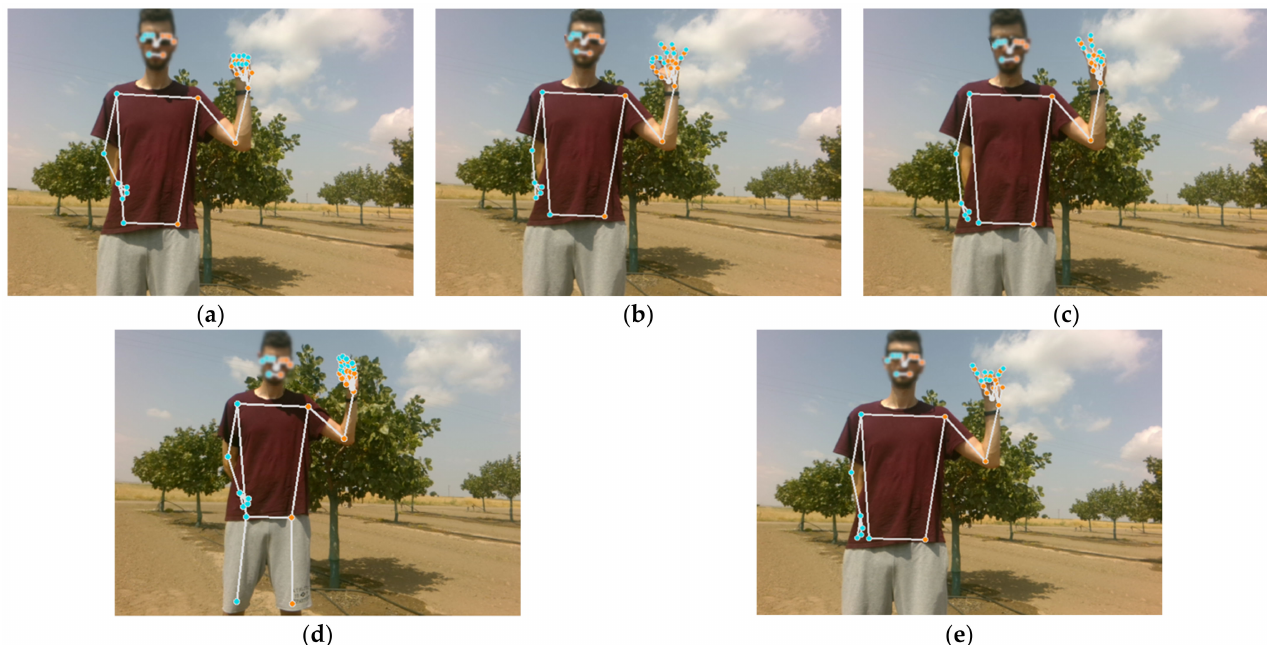
Figure 1. Images of the investigated hand gestures: ( a ) “fist”, ( b ) “okay”, ( c ) “victory”, ( d ) “flat”, and ( e )